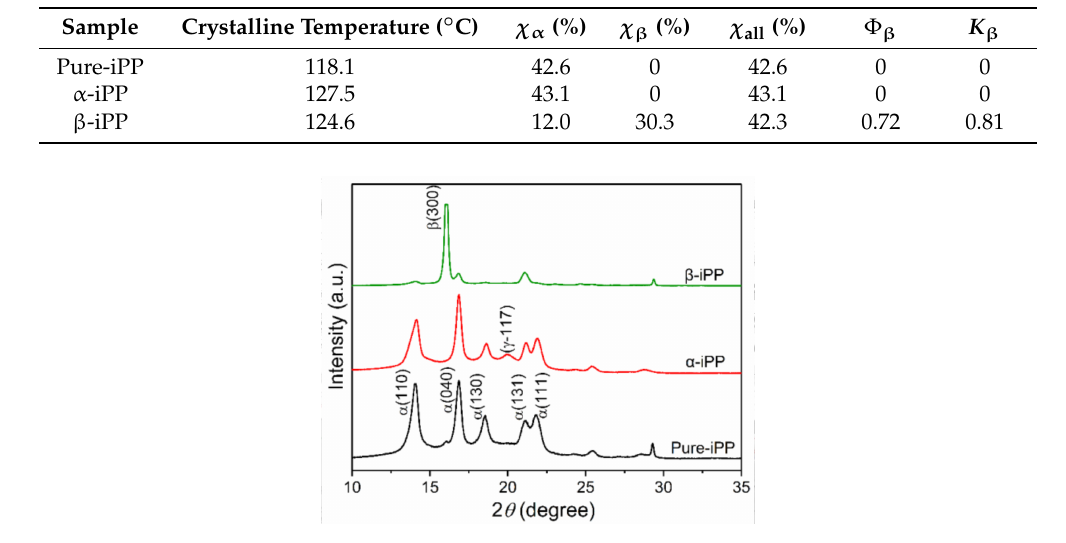
Table 1. Crystalline parameters of iPP samples based on XRD and DSC results.